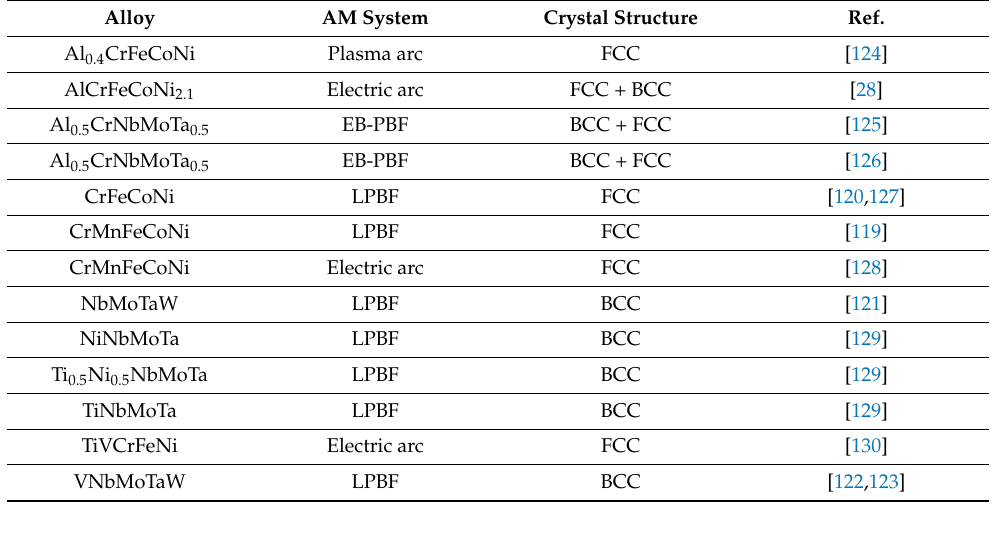
Table 4. Production of HEAs by PBF process using mix elemental powder as feedstock material.